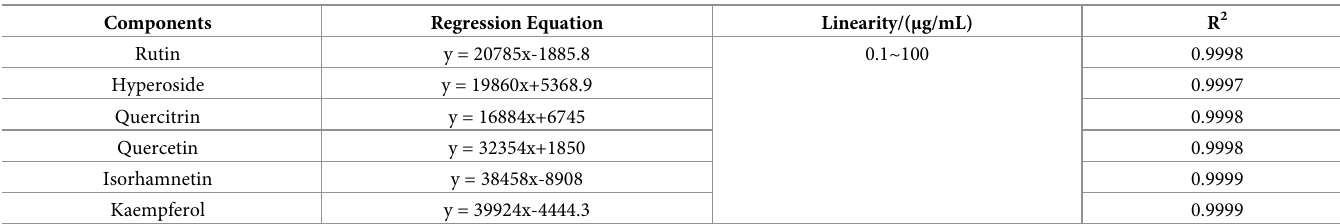
Table 2. A linear relationship between peak area (Y) and concentration (X).